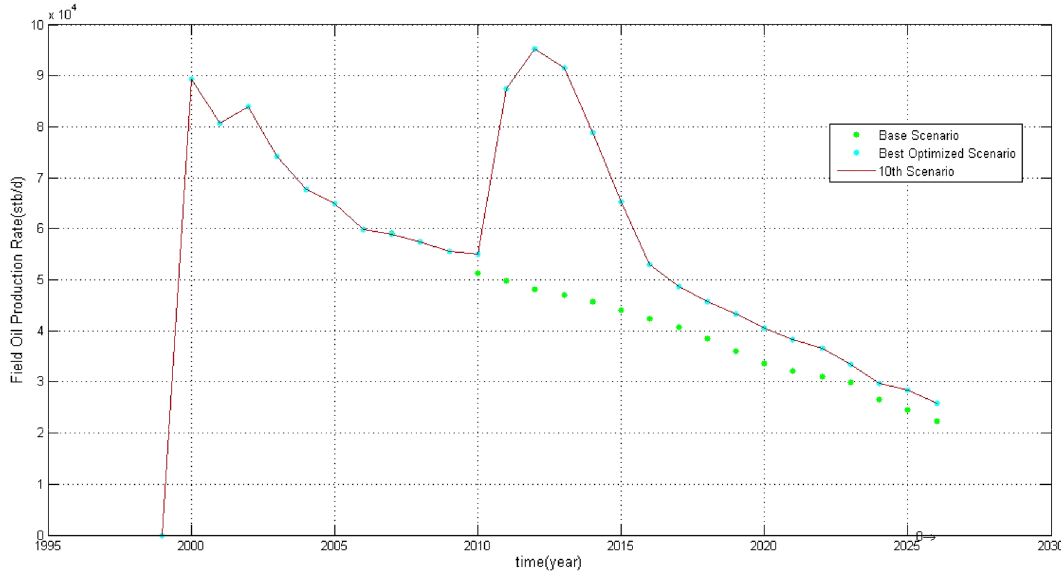
Fig. 21 Field production rate of tenth